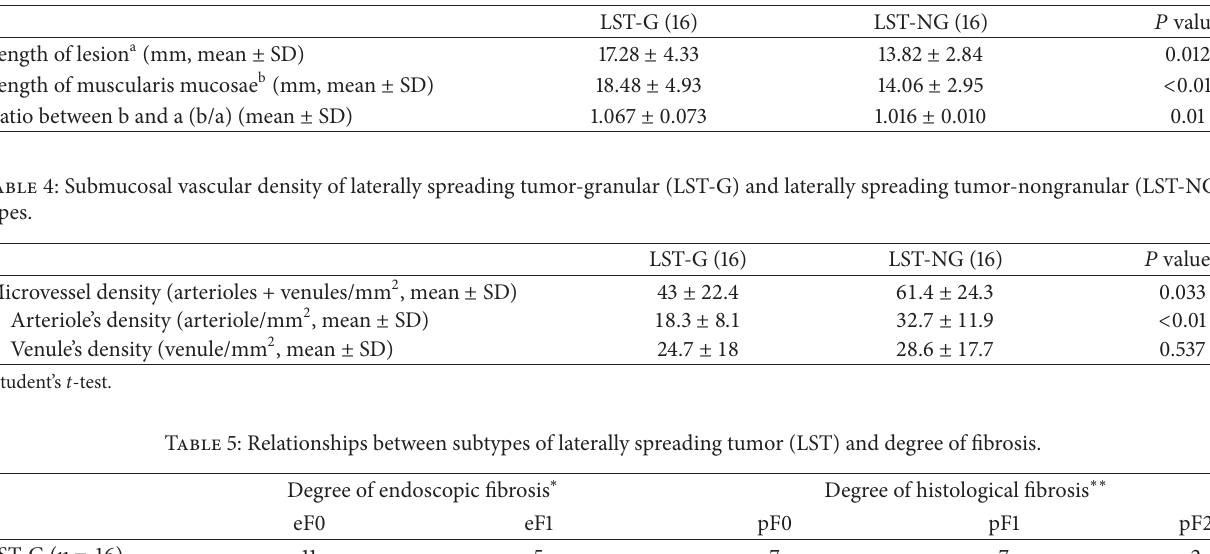
Table 3: Length of tumor and muscularis mucosae of laterally spreading tumor-granular (LST-G) and laterally spreading tumor-nongranular (LST-NG) types.